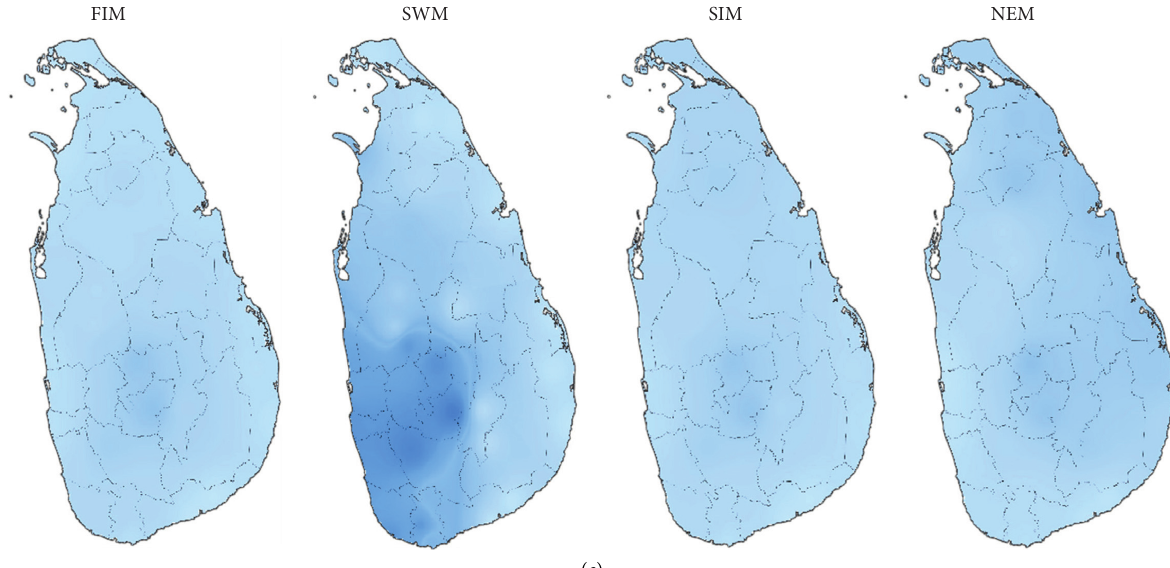
Figure 3: Near-future indices under RCP4.5 (2021–2040). (a) For normalized DI. (b) For normalized WI. (c) Moisture